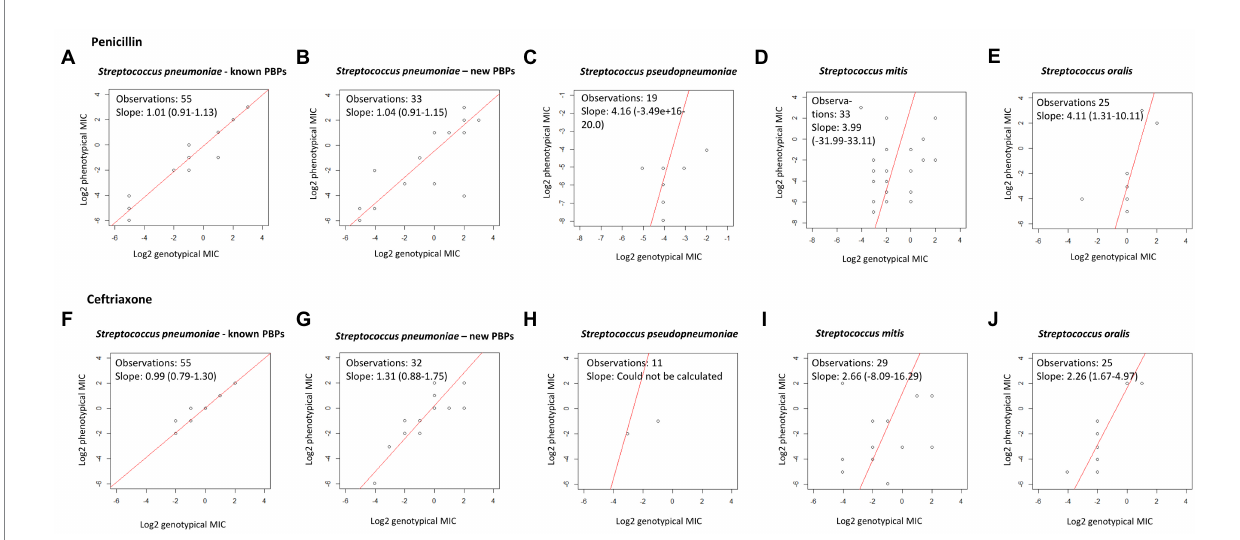
FIGURE 1 Deming regression of genotypic and phenotypic MIC for penicillin and ceftriaxone. Using log2-transformed genotypic and phenotypic MIC, statistical software R. A slope of 1 indicates exact MIC agreement. (A–E) Show results for penicillin. (F–J) Show results for